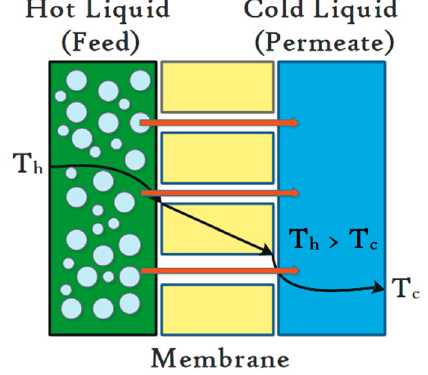
Figure 1. Schematic diagram of the MD process [10] .